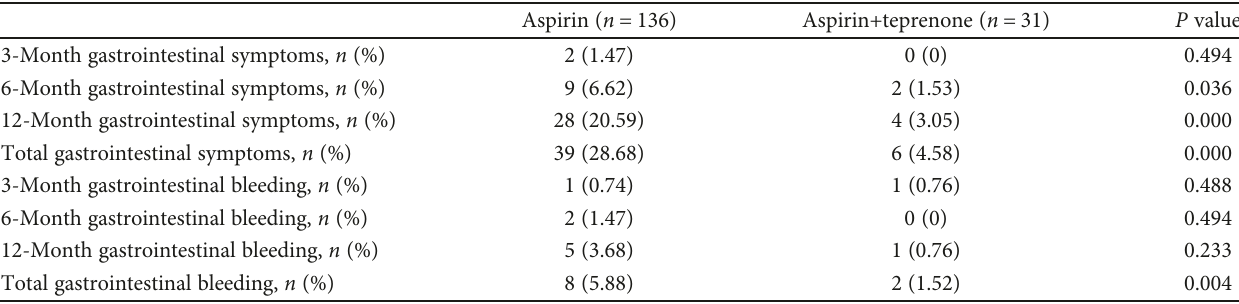
Table 2: Gastrointestinal symptoms and bleeding in patients.